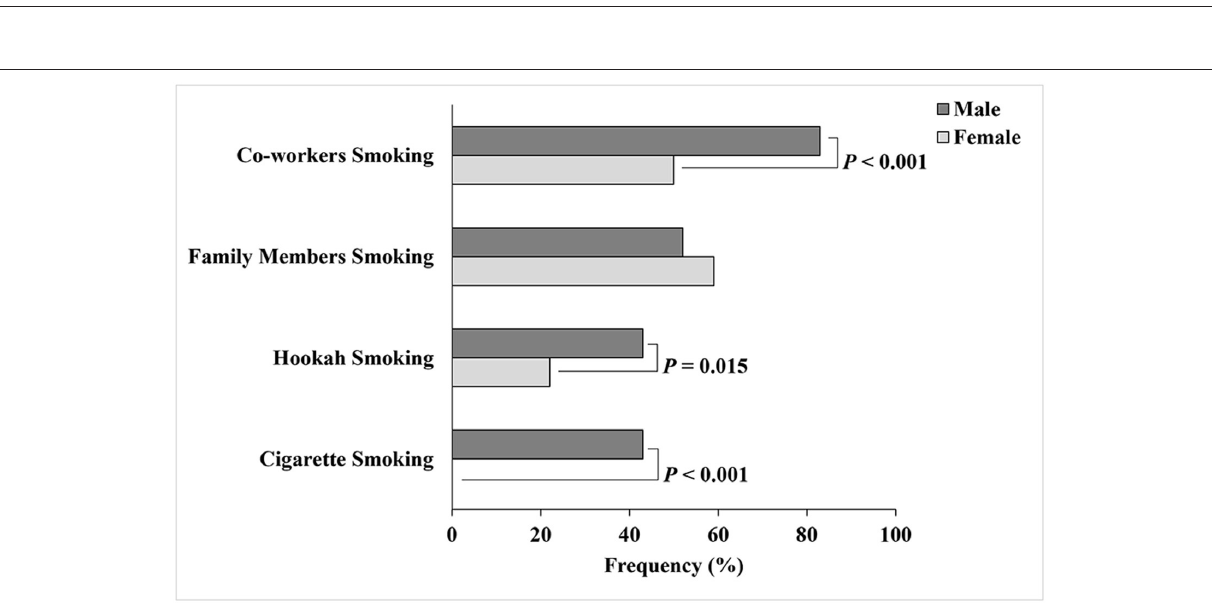
Frontiers in Nutrition |